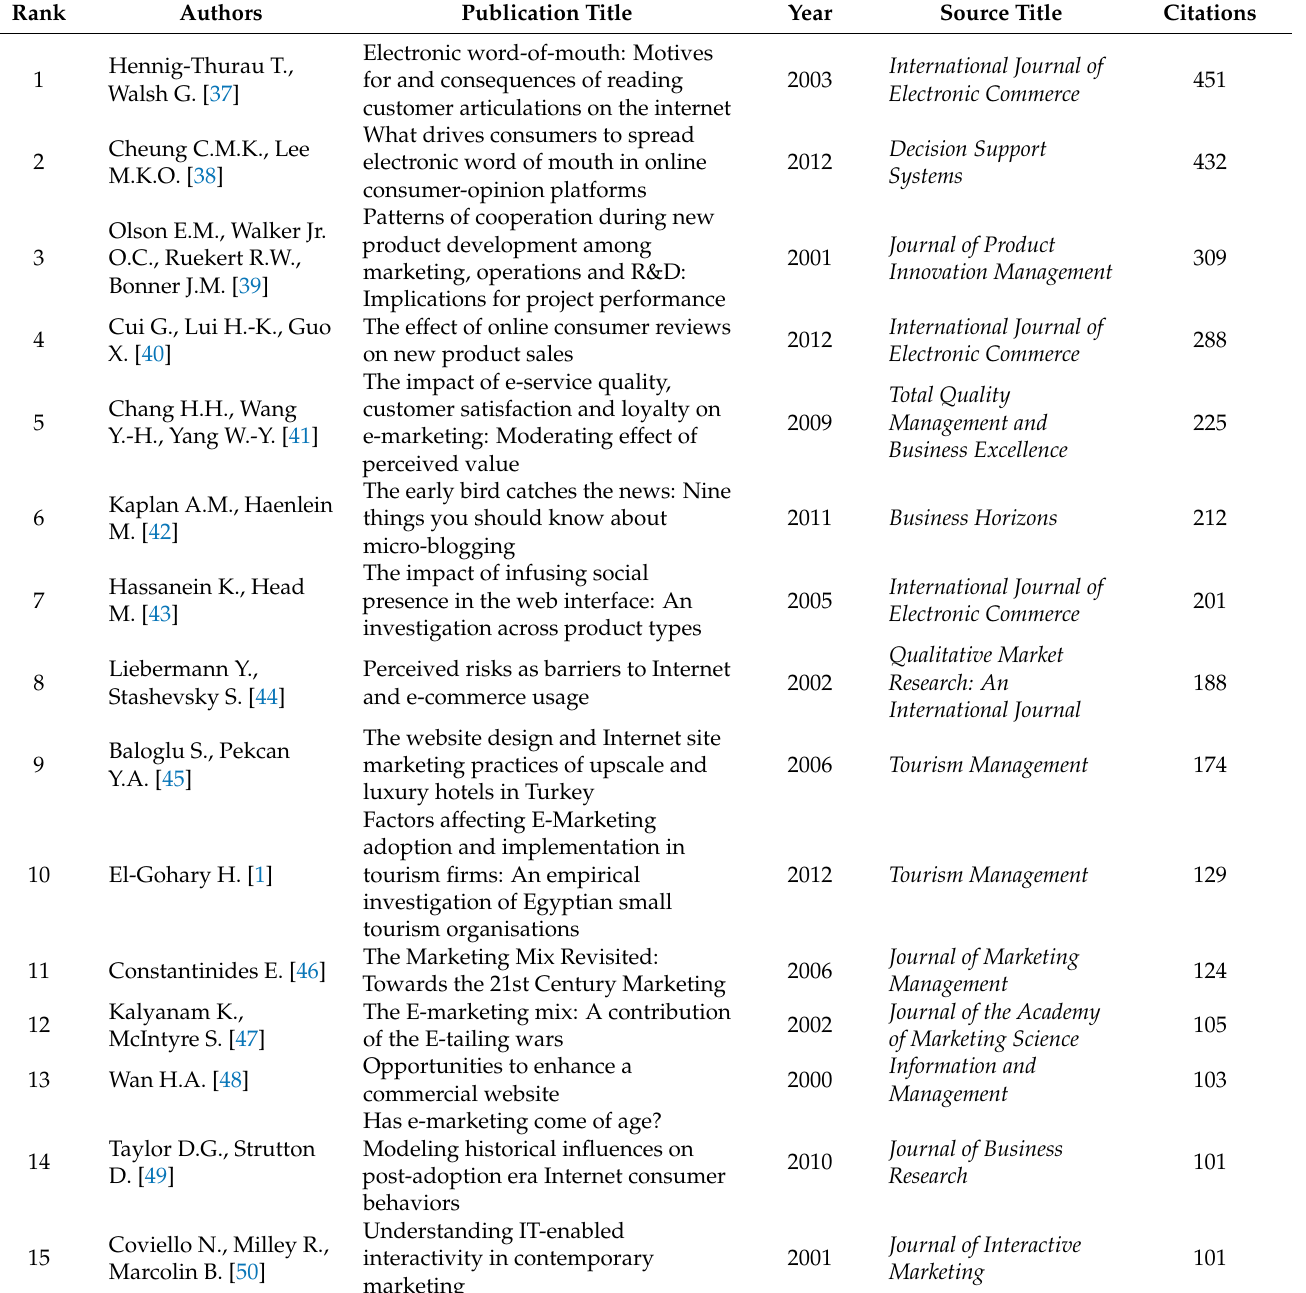
Table 7. The most cited